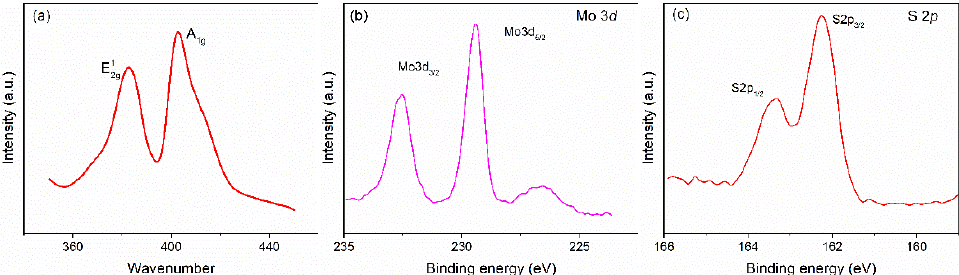
Figure 5. Characterization of the obtained nanosheets upon the substrate: ( a ) Raman data and ( b , c ) X-ray photoelectron spectroscopy (XPS) data.